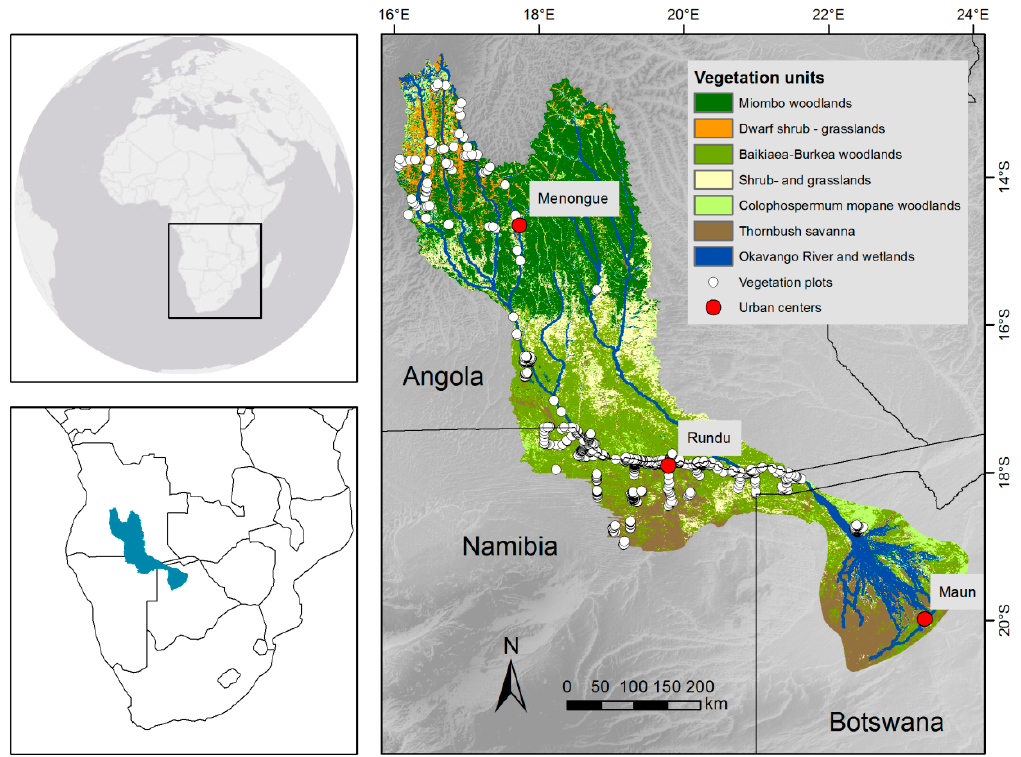
Figure 1. Location of the Okavango Basin in southern Africa. The map of the Okavango Basin shows major vegetation units modified after Stellmes et al. [39] and the location of vegetation plots used in this study. The three major urban centers of the basin, Menongue, Rundu and Maun, are indicated by a red dot. The map datum is WGS84, and the background shows the SRTM digital elevation model. The extent of the study area, the Okavango Basin, follows the definition of The Future Okavango (TFO) project [40]. For a map on observed species density, see Figure S1.